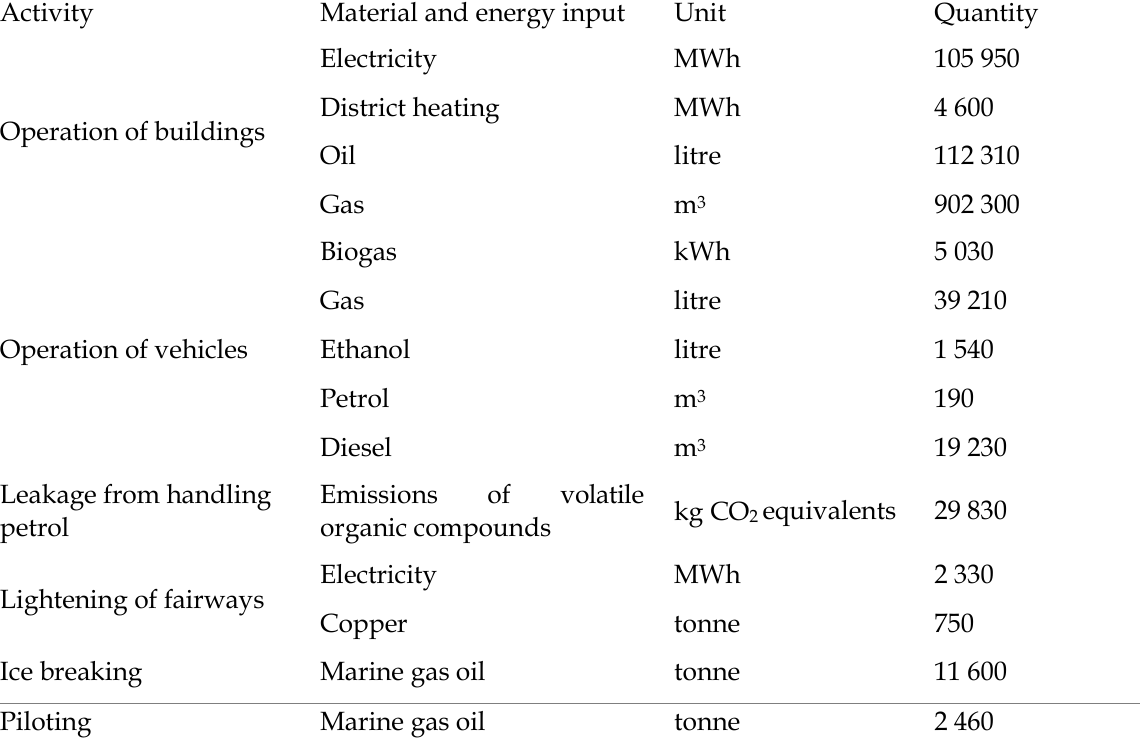
Table A11. Operation of sea transport infrastructure: material and energy input for different activities. Fuel use for vehicle operation slightly overlaps with fuel use for construction, maintenance, and reinvestment at ports, since the on-site vehicles are used for different